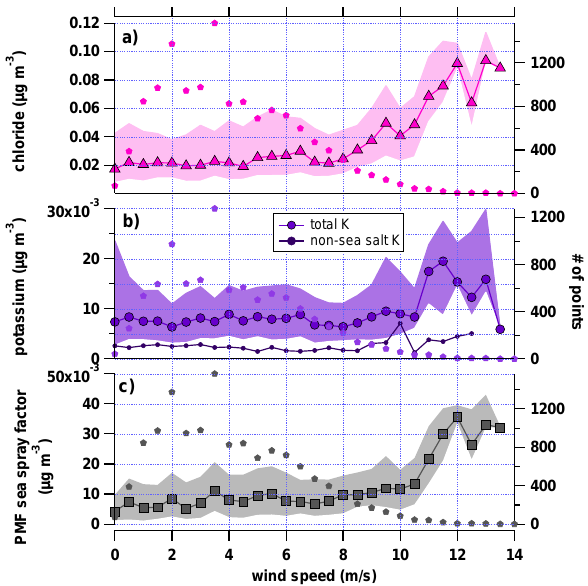
Fig. 11. PMF sea spray factor, particulate potassium (total and non- sea salt) and chloride versus wind speed at 10m above ground in bins of 0.25ms − 1 . The markers indicate the median value while the shaded areas represent the inter-quartiles. The pentagons indicate the number of samples per